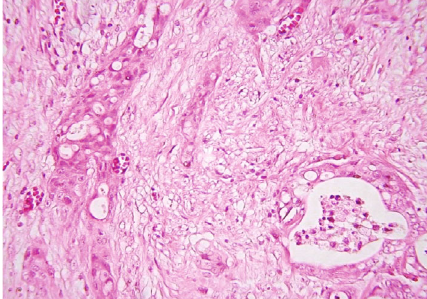
Figure 2: Tumor site distribution.